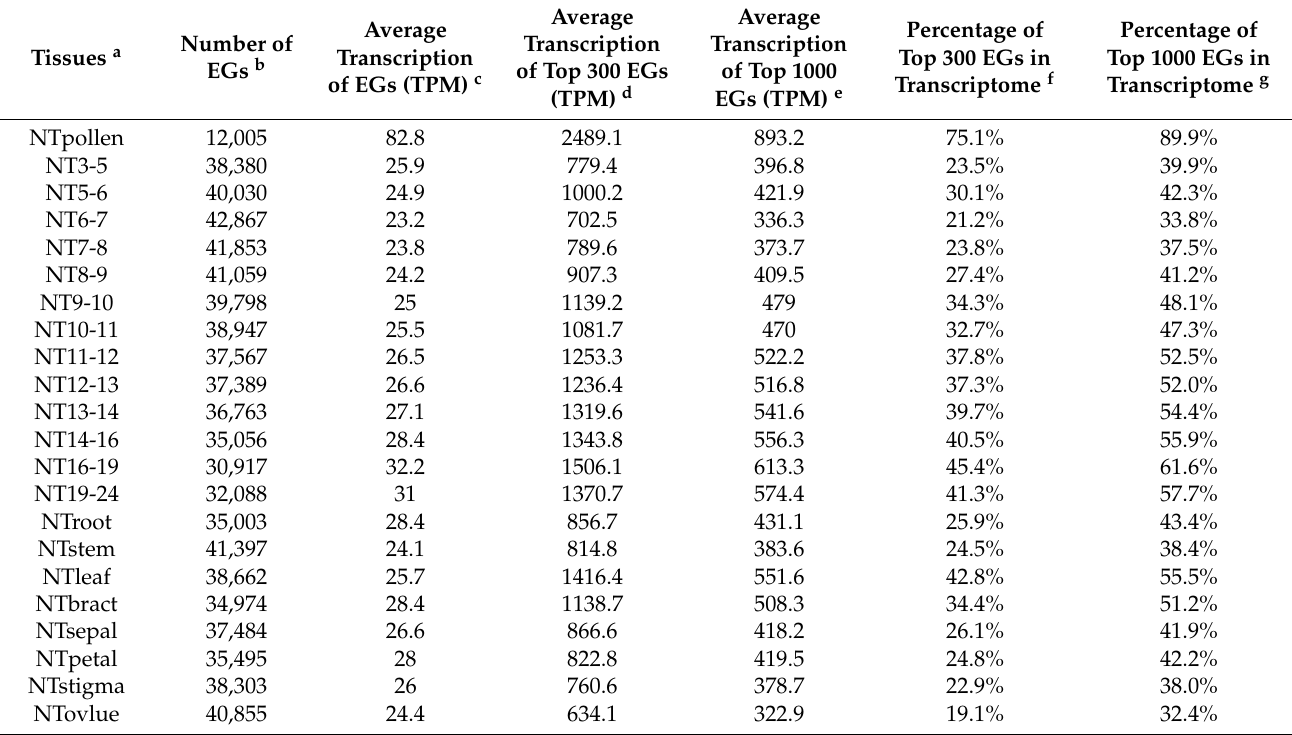
Table 1. The transcriptional levels of expressed genes (EGs), top 300 EGs, and top 1000 EGs in H05 tissue